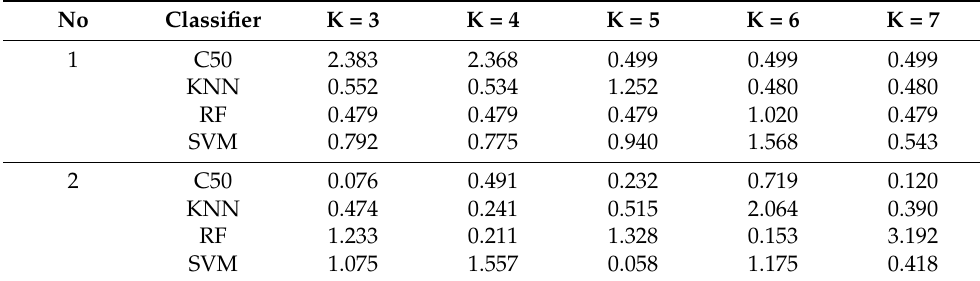
Table A1. MAI of FWS according to K (bin width =